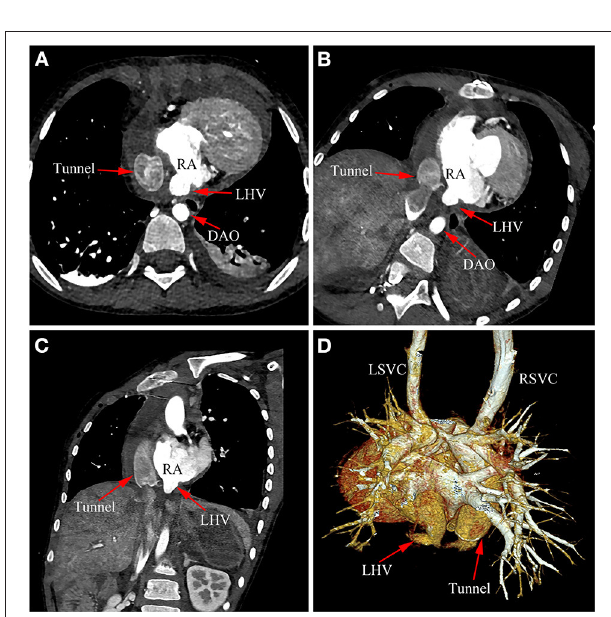
FIGURE 2 | Cardiac CT image of anomalous left hepatic venous connection. (A–D) Postoperative CT image confirmed LHV came into the right atrium. LHV, left hepatic vein; DAO, descending aorta; RA, right atrium; RSVC, right superior vena cava; LSVC, left superior vena